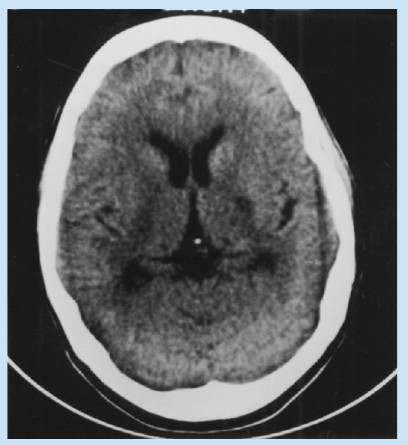
Fig. 1. Pre-contast brain scan showing oedema involving internal capsule bilaterally with faint hyperdensities.